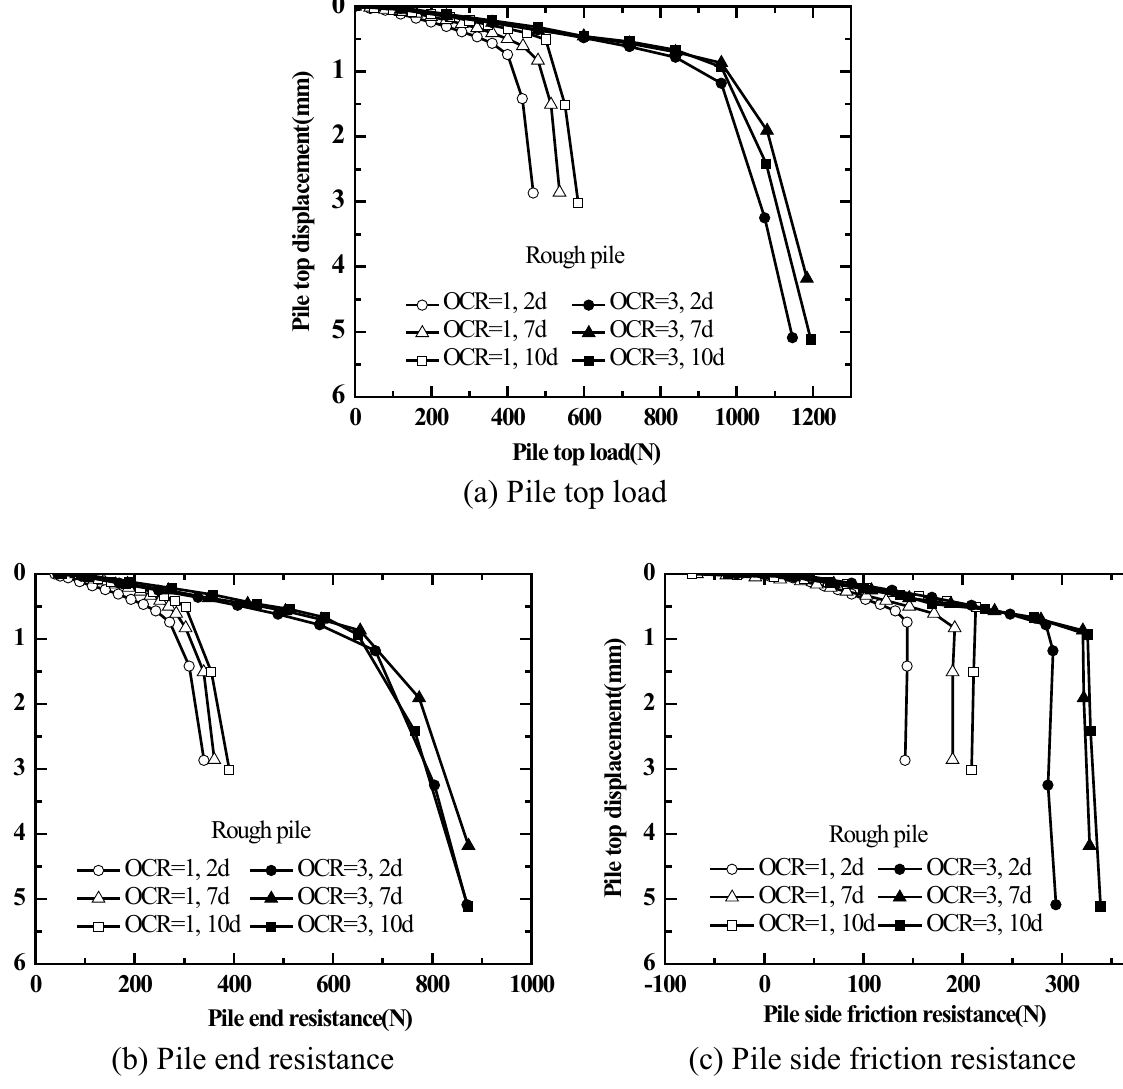
Figure11. Pile top load (Pile end resistance, Pile side friction resistance)-pile top displacement relations for rough piles under different over-consolidation